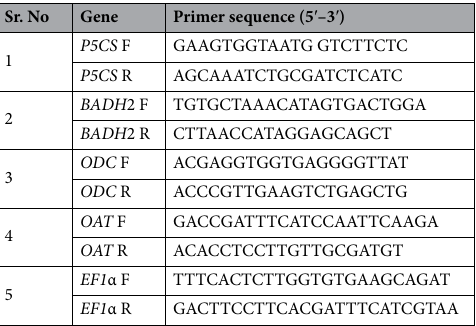
Table 2. Details of the genes and their primers used for gene expression